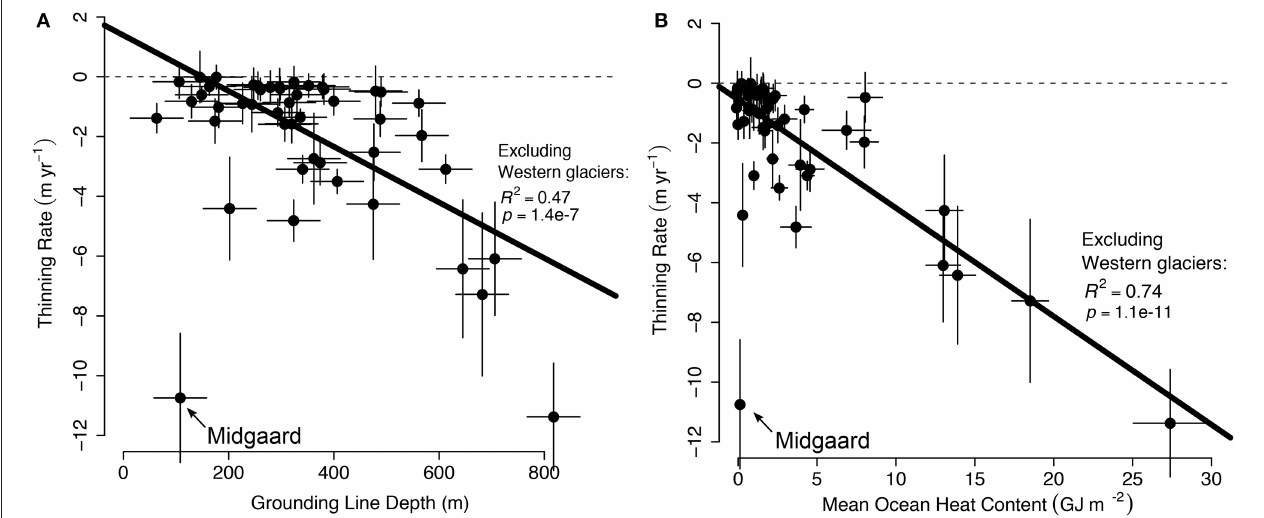
FIGURE 6 | (A) OLS regression of grounding line depth (m) with the maximum dynamic thinning rate for each catchment ( m yr − 1 ) for all glaciers except those in Western Greenland (as shown in Figure 5C ). Panel (B) shows ocean heat content (OHC) in GJ m − 2 as the independent variable. The coefficient of determination R 2 shown for all remaining